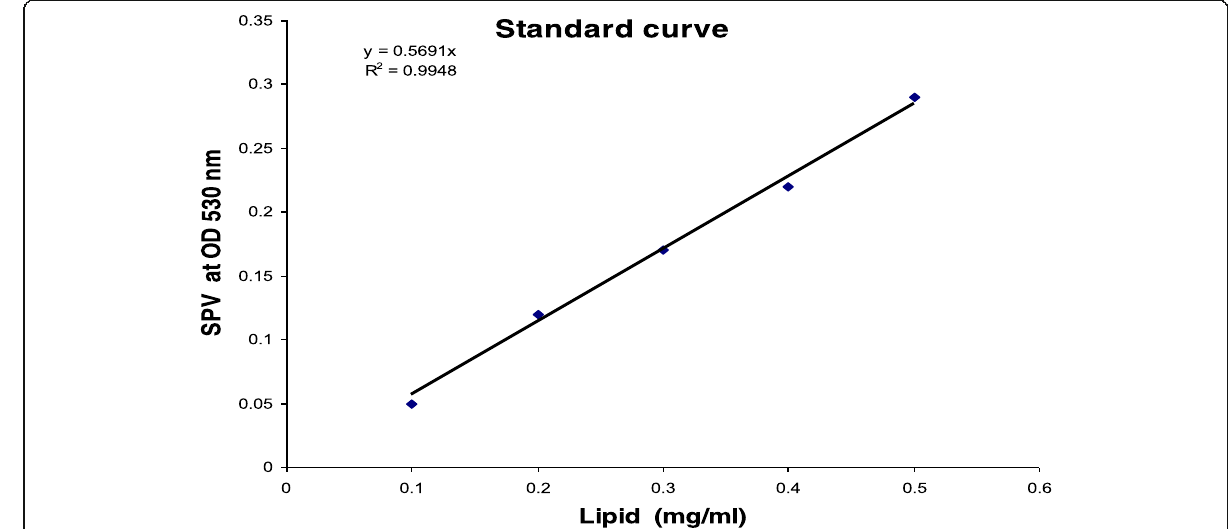
Fig. 4 Standard curve of radish oil using sulfo-phospho-vanillin reagent